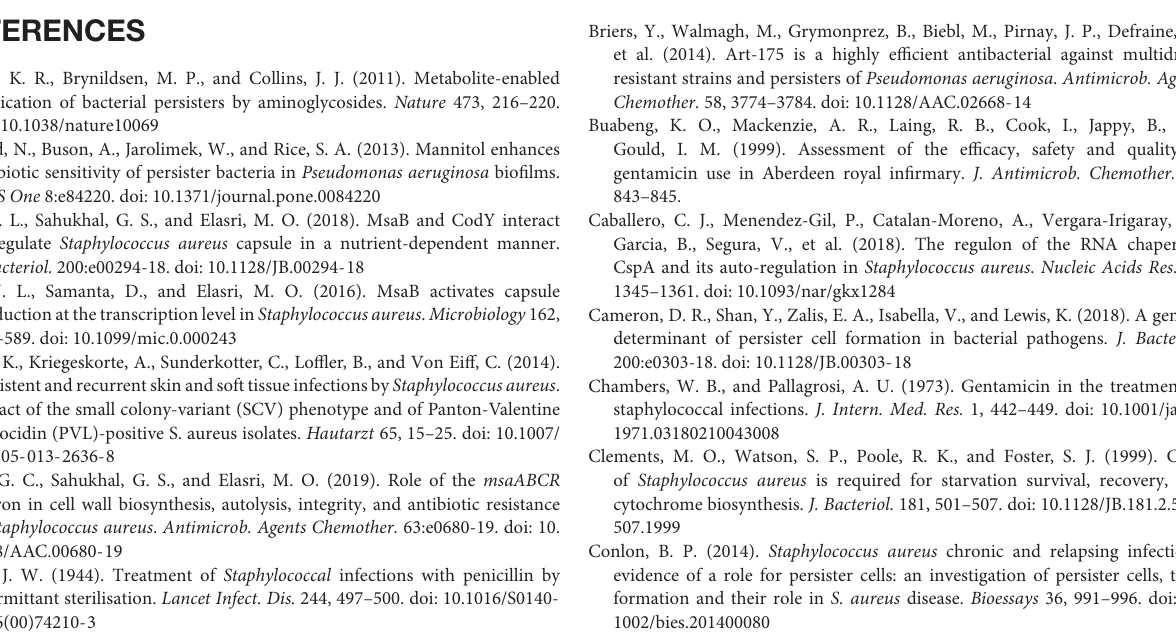
Supplementary Table 1 | Bacterial strains used in this study. Supplementary Table 2 | Primers used in this